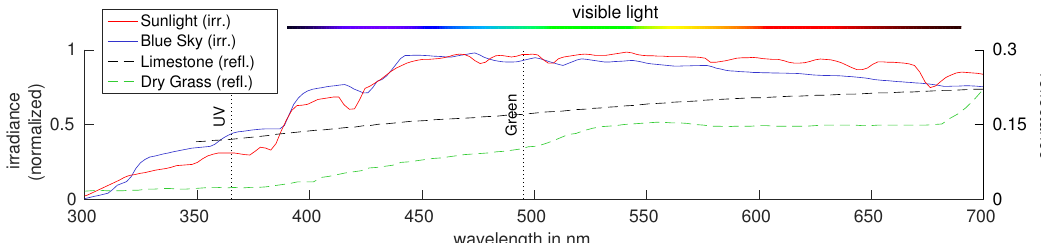
Figure 1. Irradiance spectrum (solid lines) of sunlight [7] (red), clear blue sky [8] (blue) and reflectance spectra (dashed lines) of limestone [9] (black) and dry grass [9] (green). The peaks of the glass filters used to obtain images in the UV and green channel are depicted (dotted lines). Note that the green channel is inspired by the insect Cataglyphis bicolor and does not match exactly with the perception of colors by humans (color bar). [Figure created by author from data in